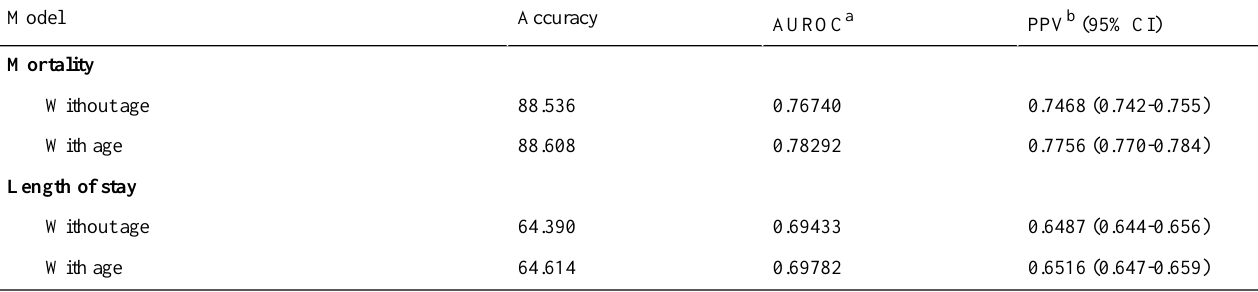
Table 15. Model results including and excluding the age